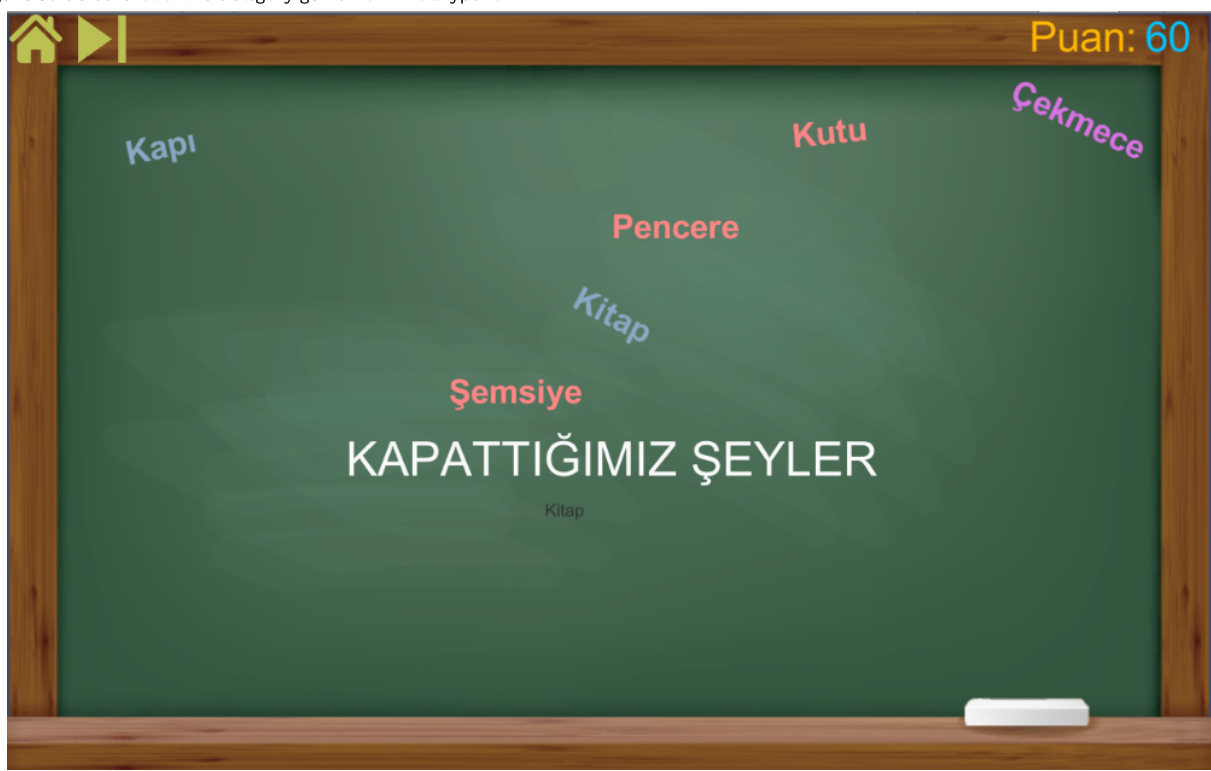
Figure 3. Screenshot of the Category game from Prototype